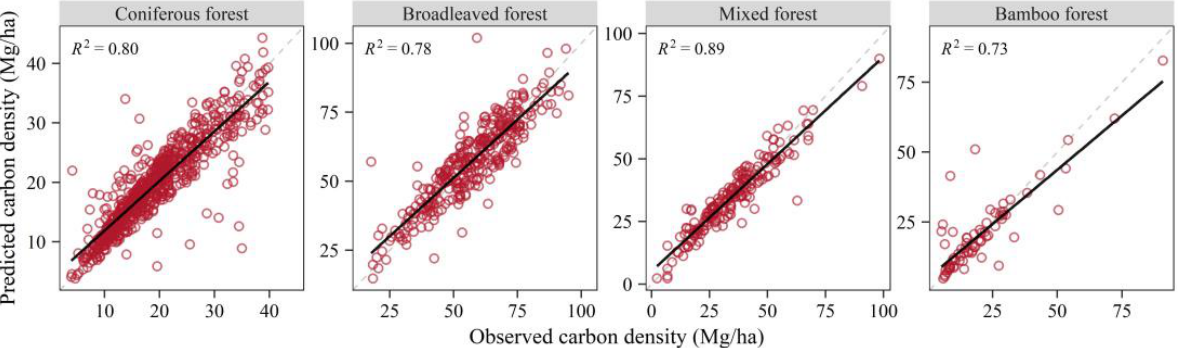
Table 5. Sample sizes of vegetation carbon storage inversion models across different forest types. Sample Size Forest Types Total Training Validation Test Coniferous forest 5006 3504 751 751 Broadleaved forest 2227 1559 334 334 Mixed forest 1293 905 194 194 Bamboo forest 480 336 72 72